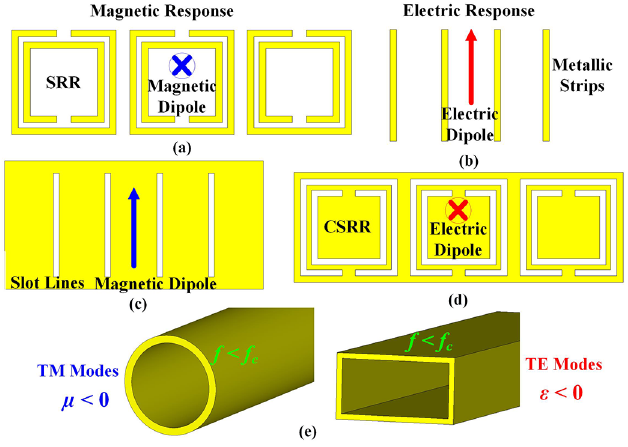
Fig. 1. MTM elements. (a) SRRs, it can be equivalent to a magnetic dipole, (b) metal wires, it can be equivalent to an electric dipole, (c) slot lines, it can be equivalent to a magnetic dipole, (d) CSRRs, it can be equivalent to an electric dipole, and (e) the empty waveguide operating below the cutoff frequency, the effective permeability is negative for the TM mode, the effective permittivity is negative for the TE mode.